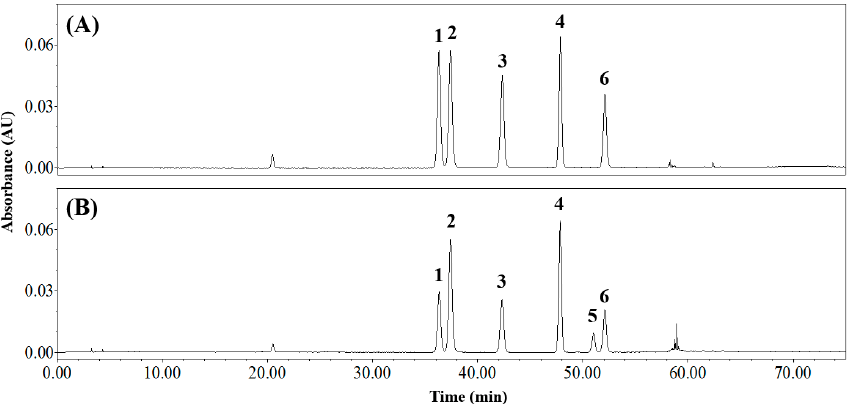
Figure 3. Reversed-phase HPLC traces of ( A ) standards and ( B ) common buckwheat sprout extract. Peak number: 1, orientin; 2, isoorientin; 3, vitexin; 4, isovitexin; 5, quercetin-3- O -robinobioside; 6,